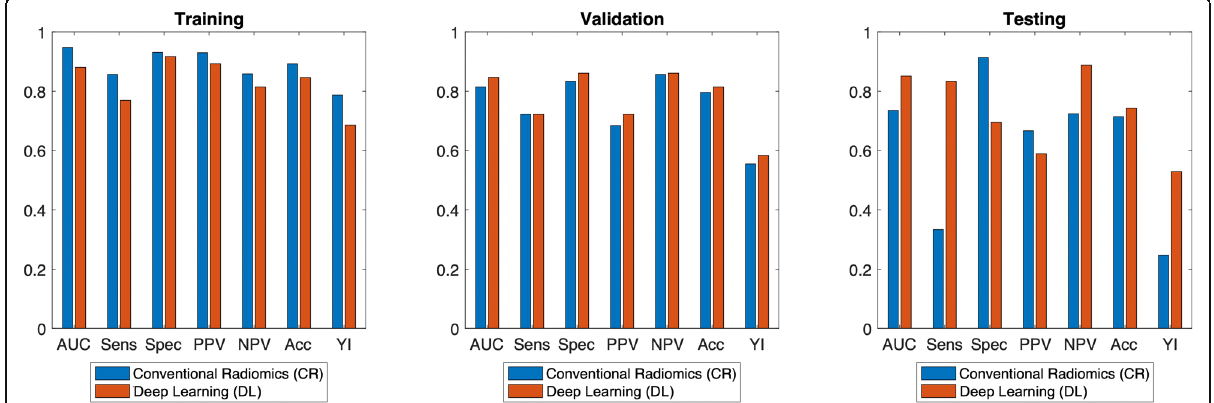
Fig. 6 Predictive performance of features including intratumoral region with CR and DLB models. The DLB model performed similarly to CR in the validation set. In the testing set, the DLB model outperformed CR in numerous metrics, including NPV, accuracy and YI. This indicates the DLB model might be more generalizable and less sensitive to pixel size differences. Note that the performance of the training set is not used for comparison due to overfitting concerns. AUC: area under the curve; Sens: sensitivity; Spec: specificity; PPV: positive predictive value; NPV: negative predictive value; Acc: accuracy; YI: Youden